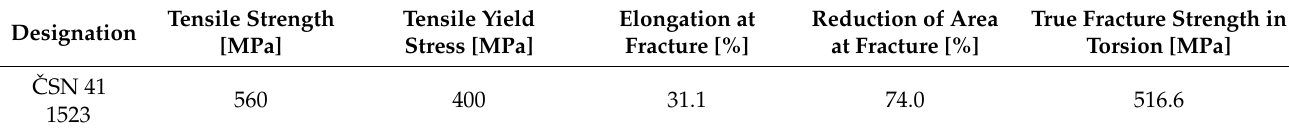
Table 1. Static material parameters and chemical composition of the studied material.